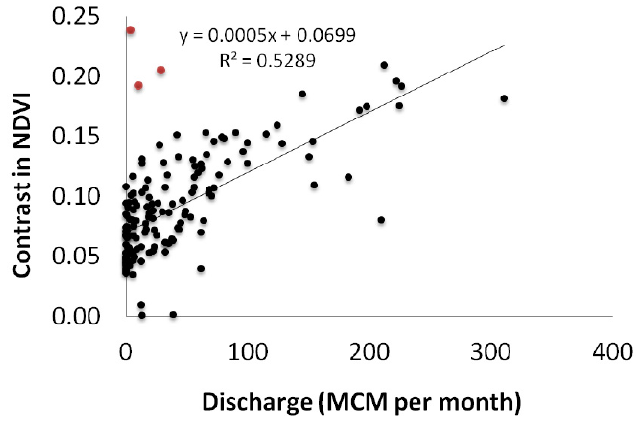
Figure 12. Relation between average discharge (MCM per month) into the swamp over the two months preceding the capture of the satellite imagery versus the contrast in NDVI between the Lorian Swamp and the surrounding rainfed area. Red symbols indicate outliers in May and June 2005 and June 2006.